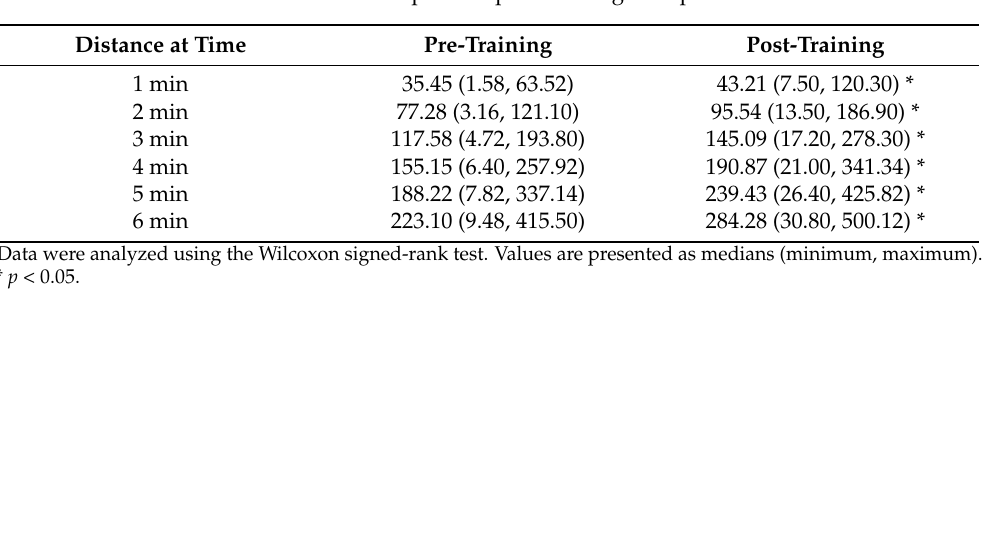
Table 3. Six-minute walk test distances at pre-and post-training time